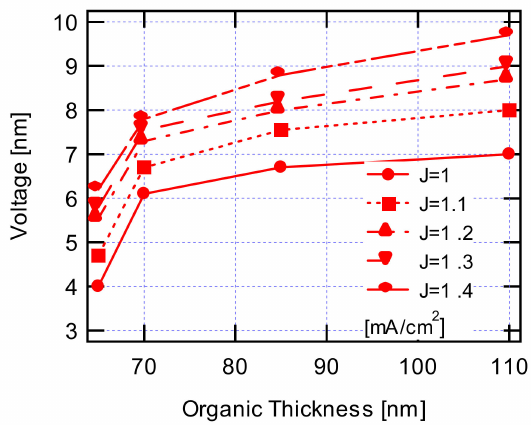
Figure 2. Operating voltage characteristics as a function of organic thickness (emission layer and hole transport layer) at various current